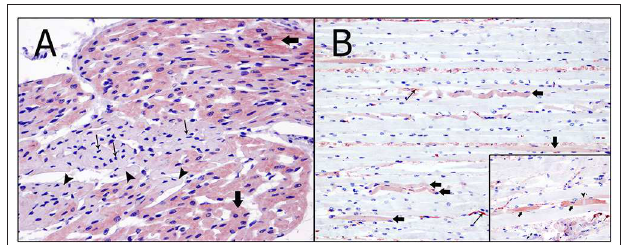
FIGURE 3 | Immunohistochemical techniques in skeletal and heart muscles. (A) Degenerated/necrotic cardiomyocytes (arrow heads), with pyknotic nucleus (thin arrows), show intrafibrillar depletion of cardiac troponin C. In contrast, normal cardiomyocytes (arrows) present an intense immunolabeling (immunohistochemical technique: anti-troponin C, magnification: 60 × ). (B) Expression of fibrinogen (arrows) in the myocytes presenting changes, including wavy fibers, hypereosinophilia and segmental hypercontraction. Immunolabeling of fibrinogen in the interior of the blood vessels can also be seen (thin arrows) (immunohistochemical technique: anti-fibrinogen, magnification: 40 × ). Inset: Necrotic myocytes (arrows) strongly expressed alongside the contraction band necrosis (arrow head) and inside the blood vessels (thin arrows) (immunohistochemical technique: anti-fibrinogen, magnification: 40 ×